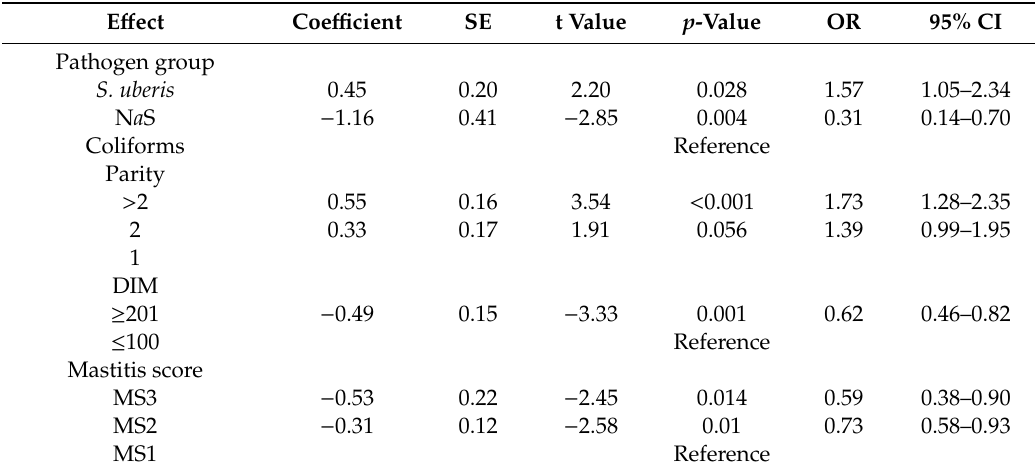
Table 9. Final mixed logistic regression model for recurrent cases of clinical mastitis from 12 di ff erent herds in Northern